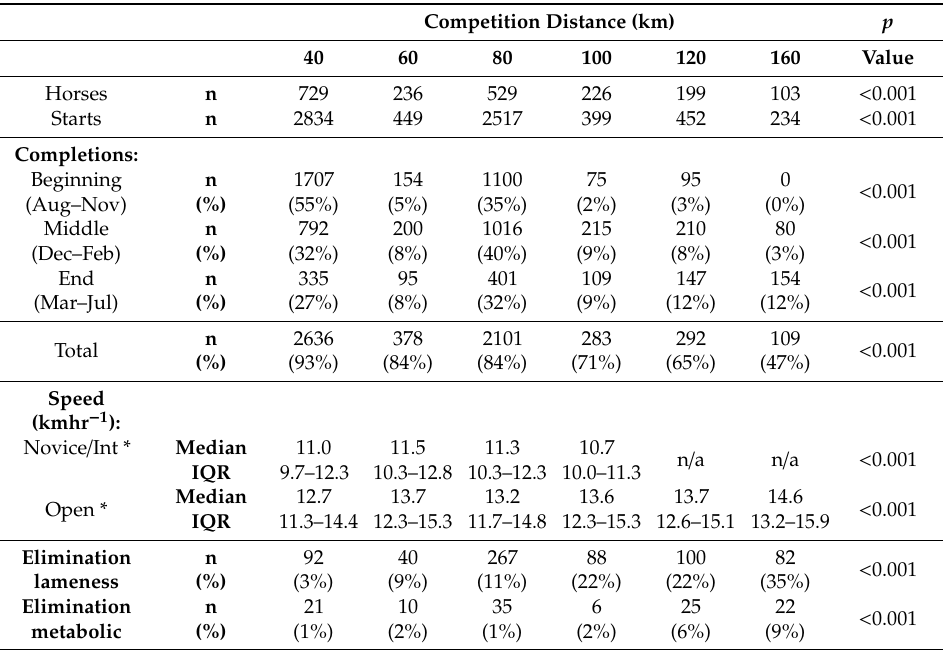
Table 1. Characteristics of competition distances over six endurance competition seasons 2010 / 11–2015 / 6 in New Zealand.